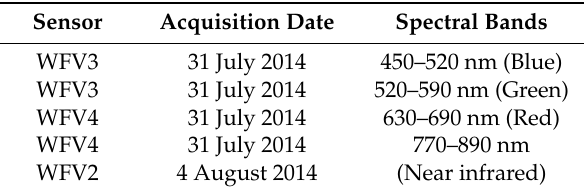
Table 1. Details of the GF-1 wide-field view (WFV) data used and its properties.